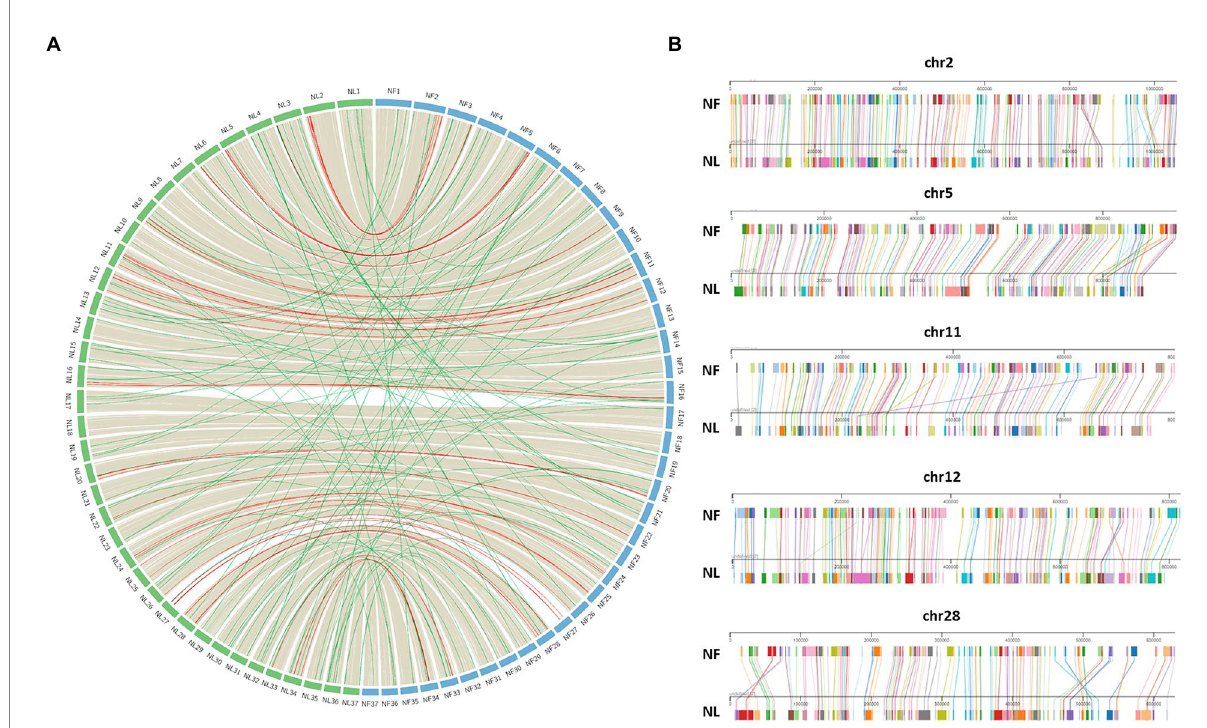
FIGURE 6 Synteny between Naegleria fowleri and Naegleria lovaniensis using core-genes. (A) In the circos plot, protein coding genes of N. fowleri (NF_NF1 strain, blue) can be connected with those of N. lovaniensis (NL_Lova7, green) if they belong to the core-genome. Preliminary anchoring of scaffolds using a 37 pseudo-molecules reference (NF_TY) during the assembly process, genes can be positioned onto 37 newly assembled pseudo-molecules references. Each species’ chromosome is labeled with the genus species abbreviation (NF for N. fowleri and NL for N. lovaniensis ). Highly conserved syntenic blocks between the genomes are colored in gray, gene order rearrangement on the same chromosome are highlighted in red while gene order rearrangement on different chromosomes are highlighted in green. (B) Focus on chromosomes that show gene order rearrangement within the same chromosome using Mauve viewer. Pairwise chromosomal synteny between gene homologs of N. fowleri and N. lovaniensis in chromosomes 2, 5, 11, 12, and 28. Each colored box corresponds to a distinct core-gene that can be connected between the two reference